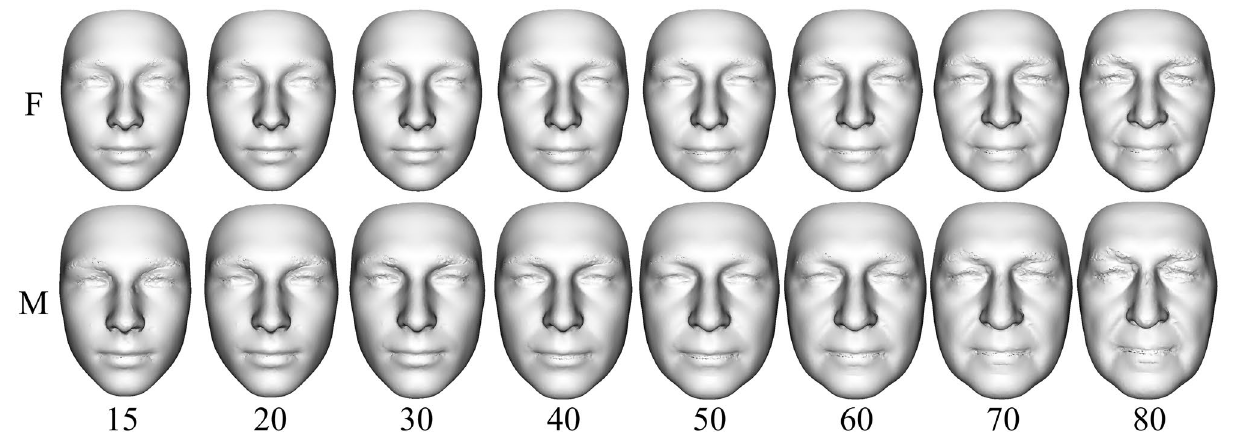
Figure 3. Predicted synthesized facial models for 15, 20, 30, 40, 50, 60, 70 and 80 years of ages created using 200 PC contributions to the mean form (F—females,